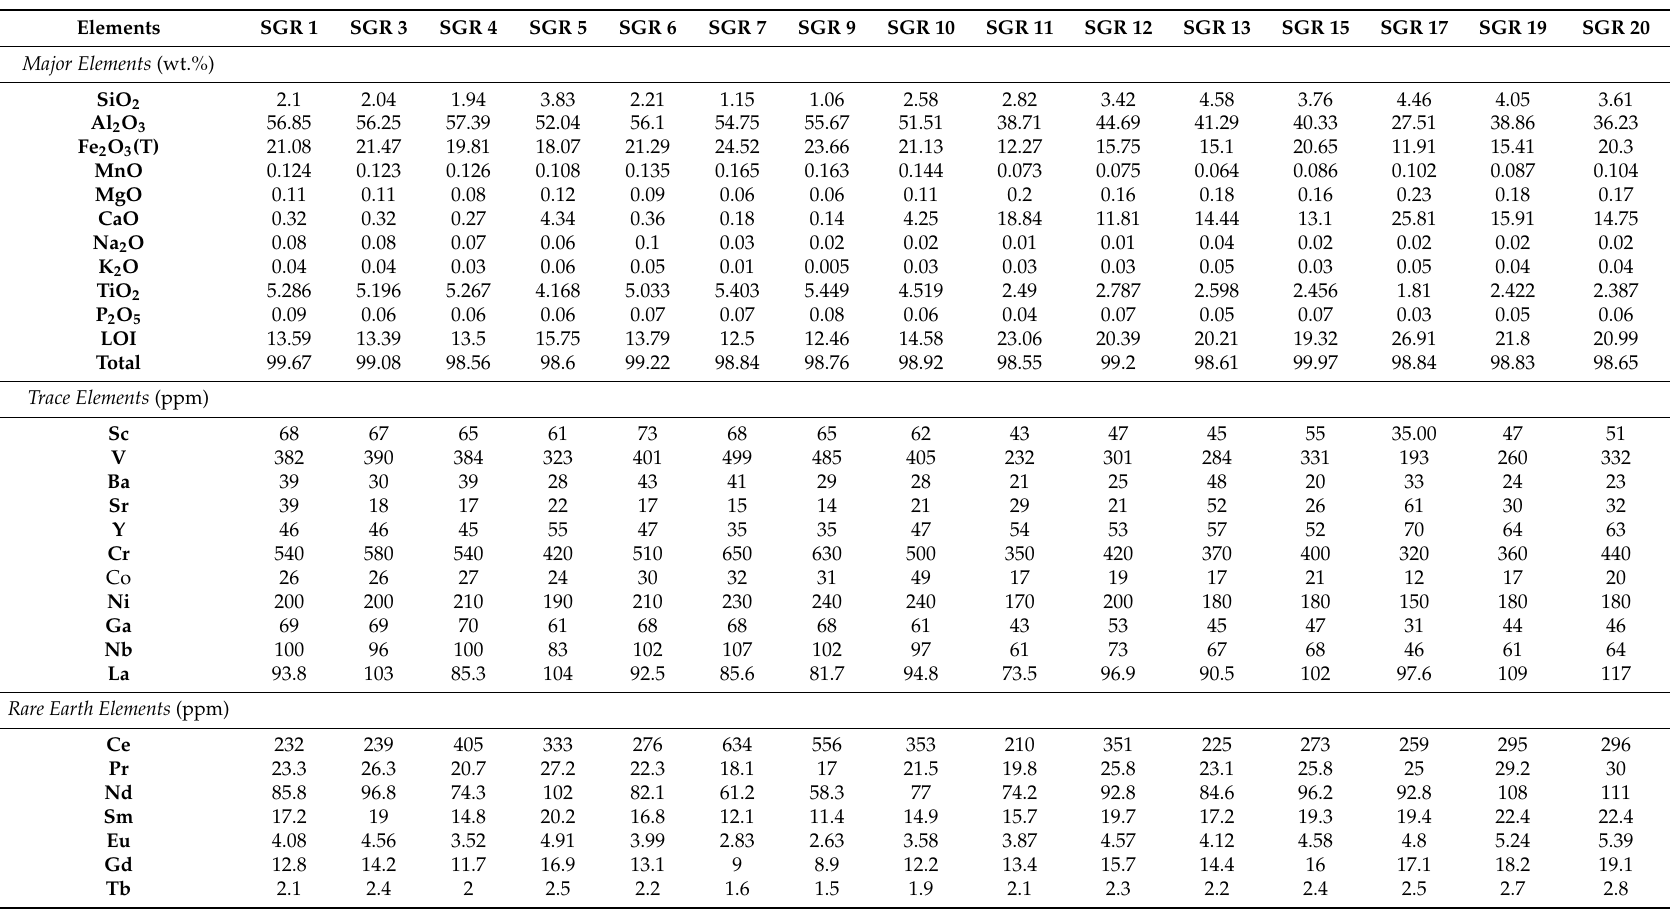
Table 1. Chemical composition of the San Giovanni Rotondo (SGR)